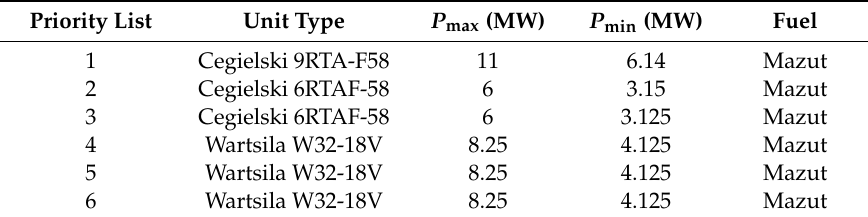
Table 1. Technical characteristics of Samos Island diesel power units.